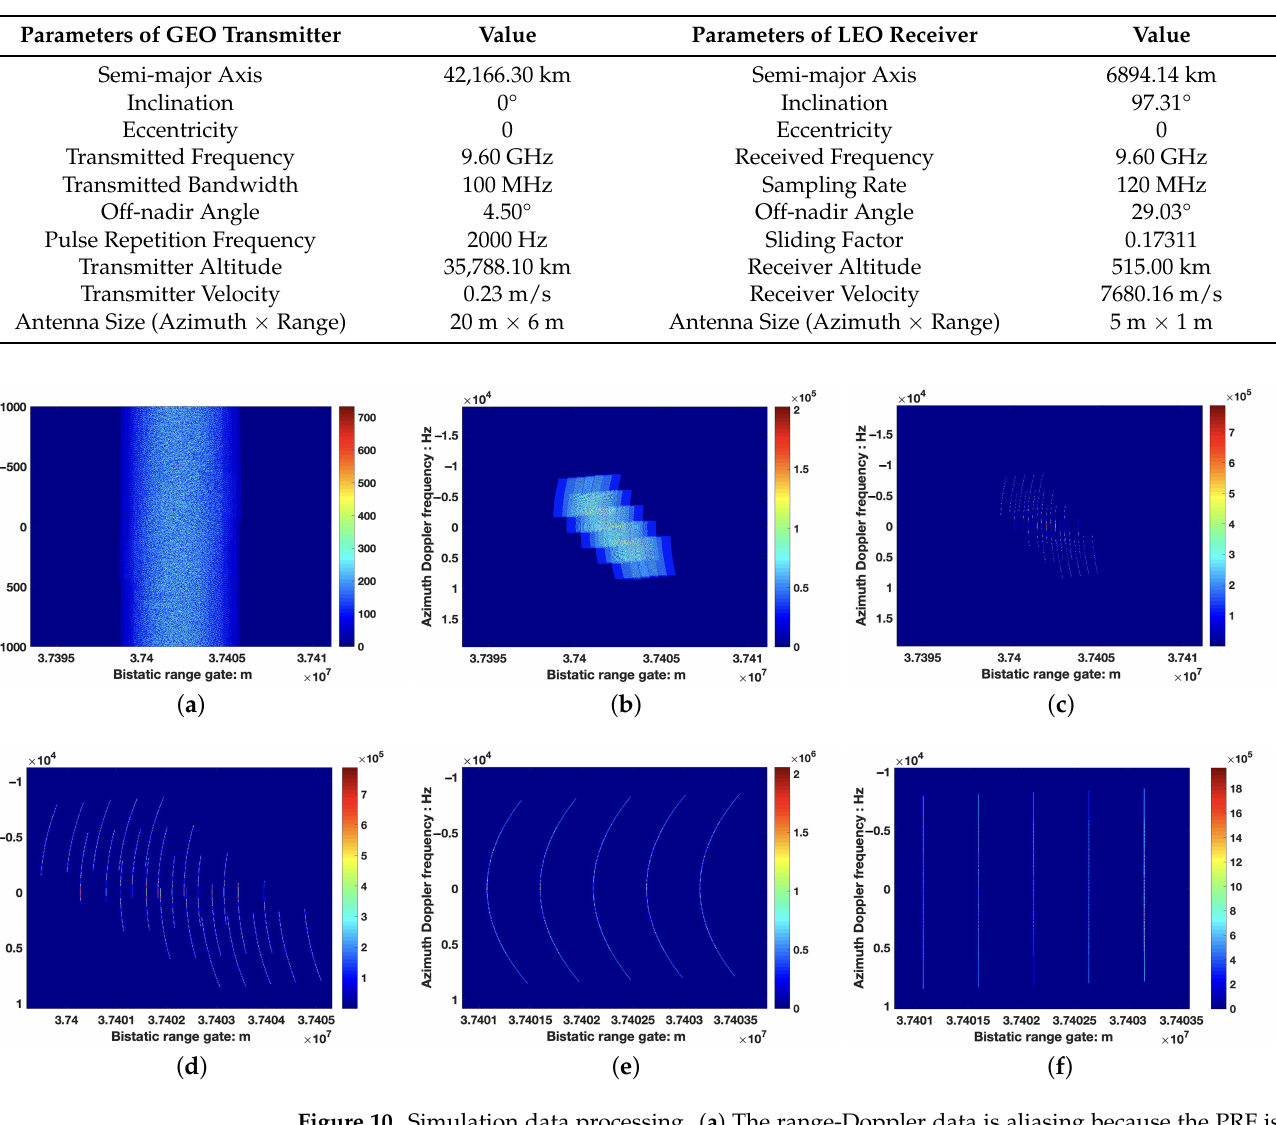
Table 1. Simulation experiment parameters of GTLR-BiSAR sliding spot mode.